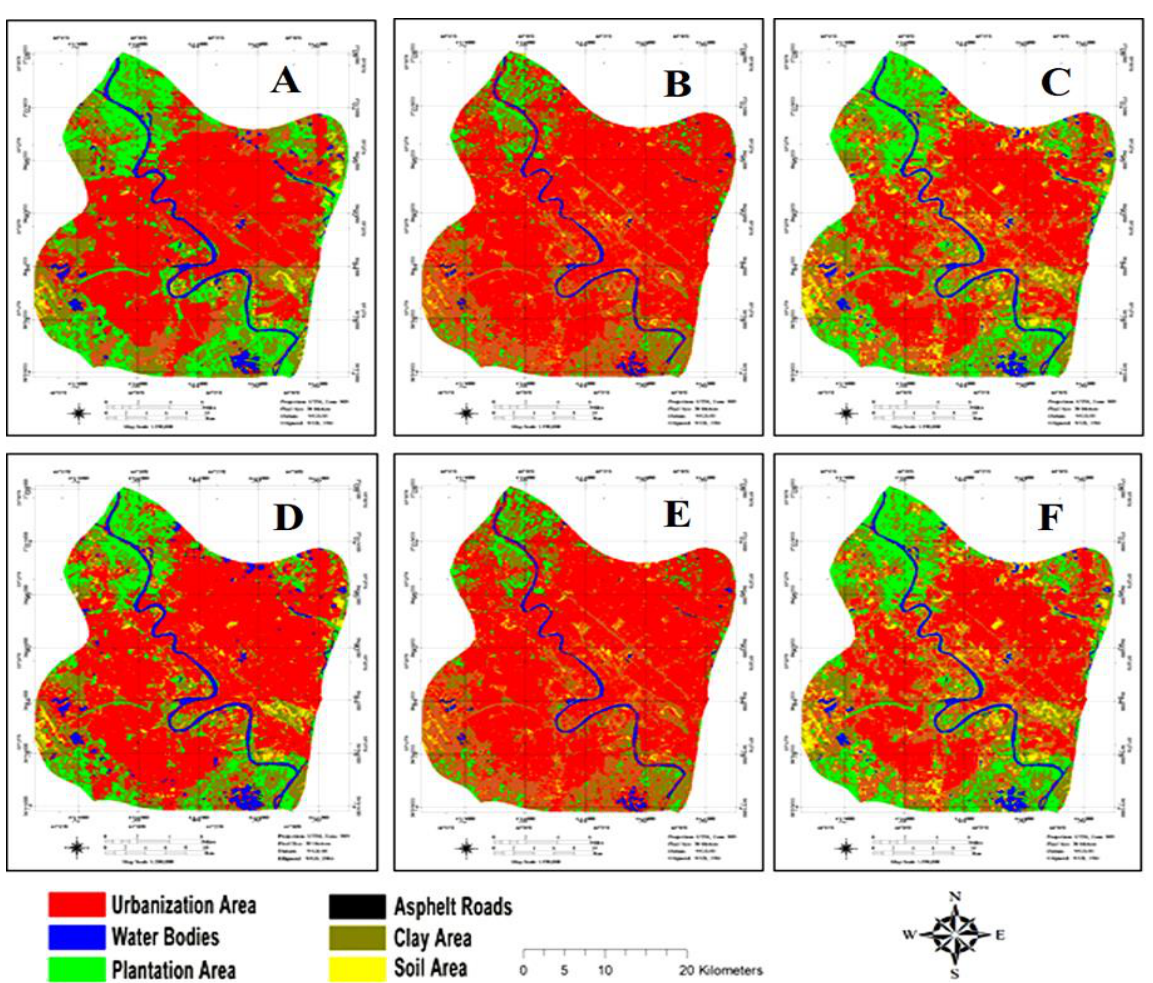
Figure 7. The classified images used the visible datasets and the pan-sharpening with a combination of the visible and thermal data of 2020; (A) the ANN algorithm on the visible images; (B) the MD algorithm on the visible images; (C) the ML algorithm on the visible images; (D) the ANN algorithm on the pan-sharpening with the combination images; (E) the MD algorithm on the pan-sharpening with the combination images; and (F) the ML algorithm on the pan-sharpening with the combined